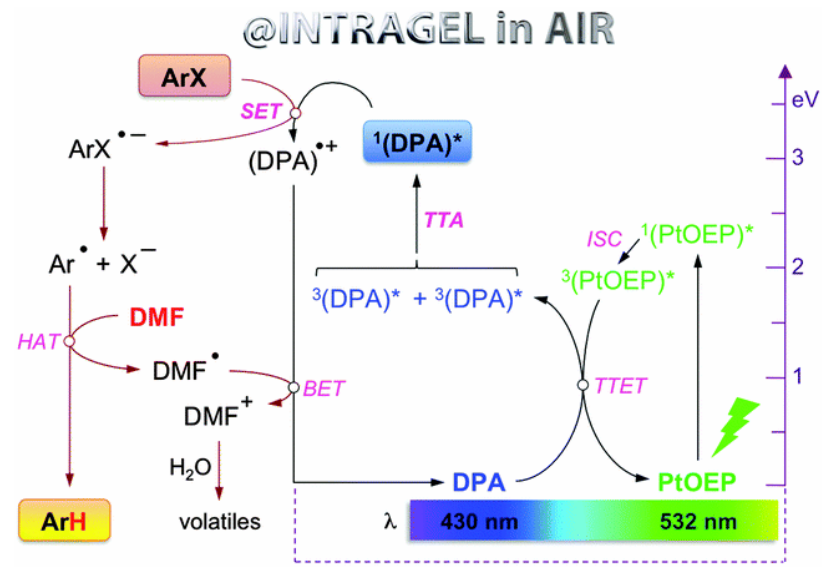
Figure 4. Proposed mechanism of the visible-light-triggered photoreduction of aryl halides under aerobic and room temperature conditions, in which the symbol * refers to the excited state. Reprinted with permission from ref. [86]. Copyright The Royal Society of Chemistry 2015.